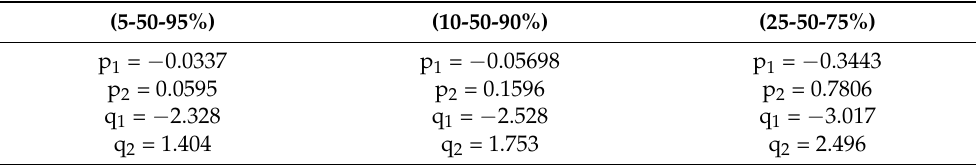
Table 4. Parameters {p i , q i } of the rational function f2( α ) for the different sets of symmetrical